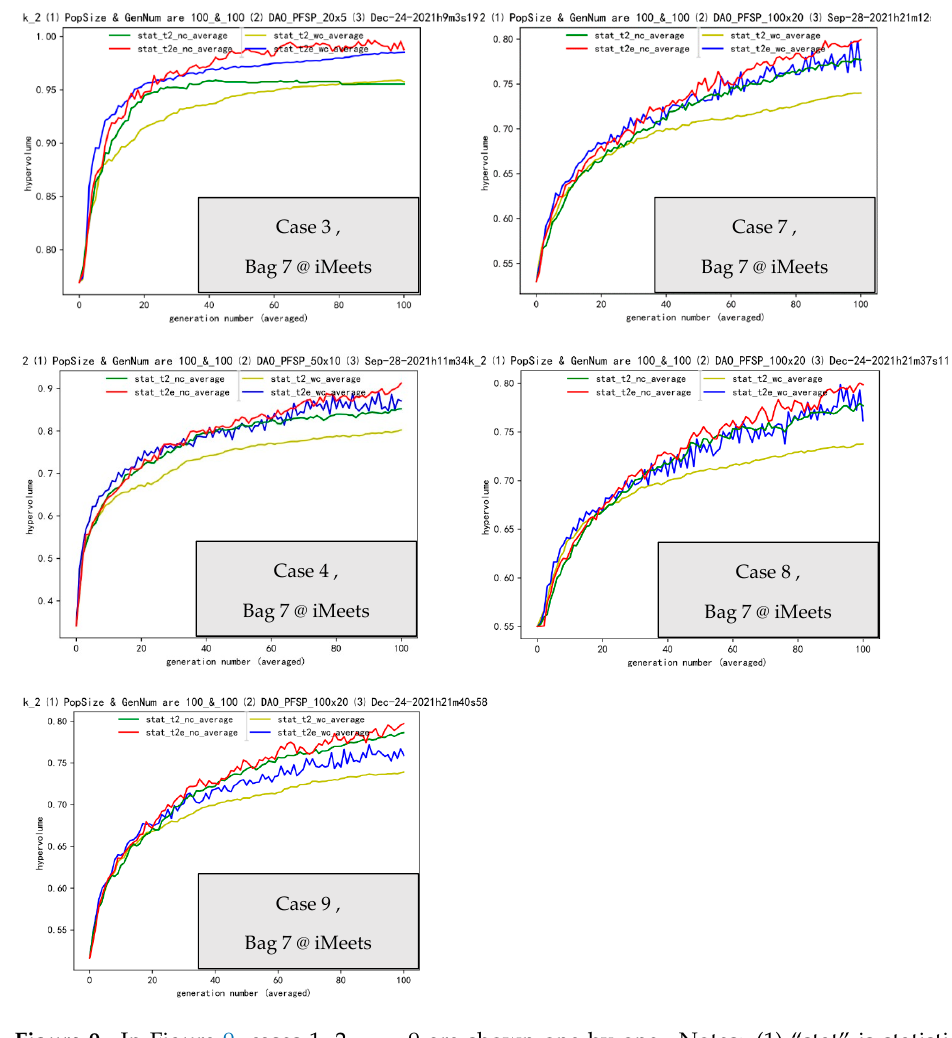
Figure 9. In Figure 9, cases 1, 2, ..., 9 are shown one by one. Notes: (1) “stat” is statistics of hypervolume containing both Cmax objective and TFT objective towards full Pareto characterization for solution evaluation; and (2) actually, t2_nc is the baseline setting of NSGAII, without clustering and transferring tools. We study the auxiliary tasks and their transfer coefficients here.